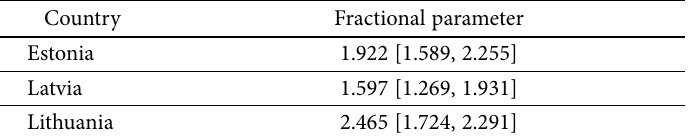
Table A1. Fractional differencing parameter Country Fractional